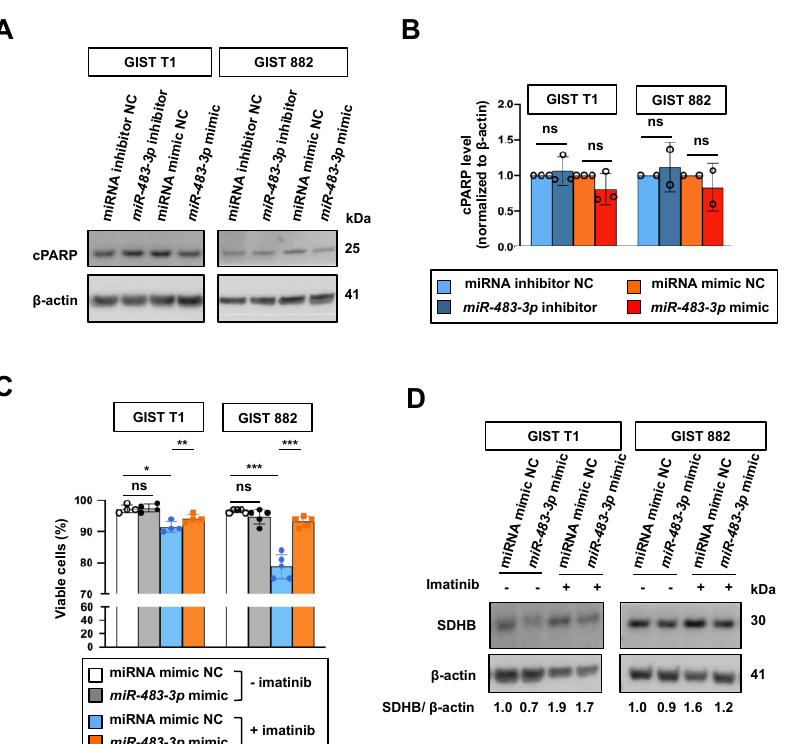
Figure 5. Effect of miR-483-3p regulation on cell viability with and without imatinib treatment. ( A ) Western blots showing the effect of miR-483-3p inhibition or overexpression on cleaved PARP (cPARP) expression in GIST cell lines. β -actin was used as a loading control. ( B ) Quantification of cPARP protein level in ( A ). ( C ) GIST cells were transfected with miR-483-3p mimic or NC for 24 h, followed by imatinib treatment for another 24 h. Cell viability was assessed by trypan blue staining. ( D ) Western blots showing the effect of miR-483-3p overexpression on SDHB protein level after 48 h of imatinib treatment. * p < 0.05, ** p < 0.01, *** p < 0.001, ns = not significant by paired t-test. Error bars represent SD. Each replicate is depicted by a dot.